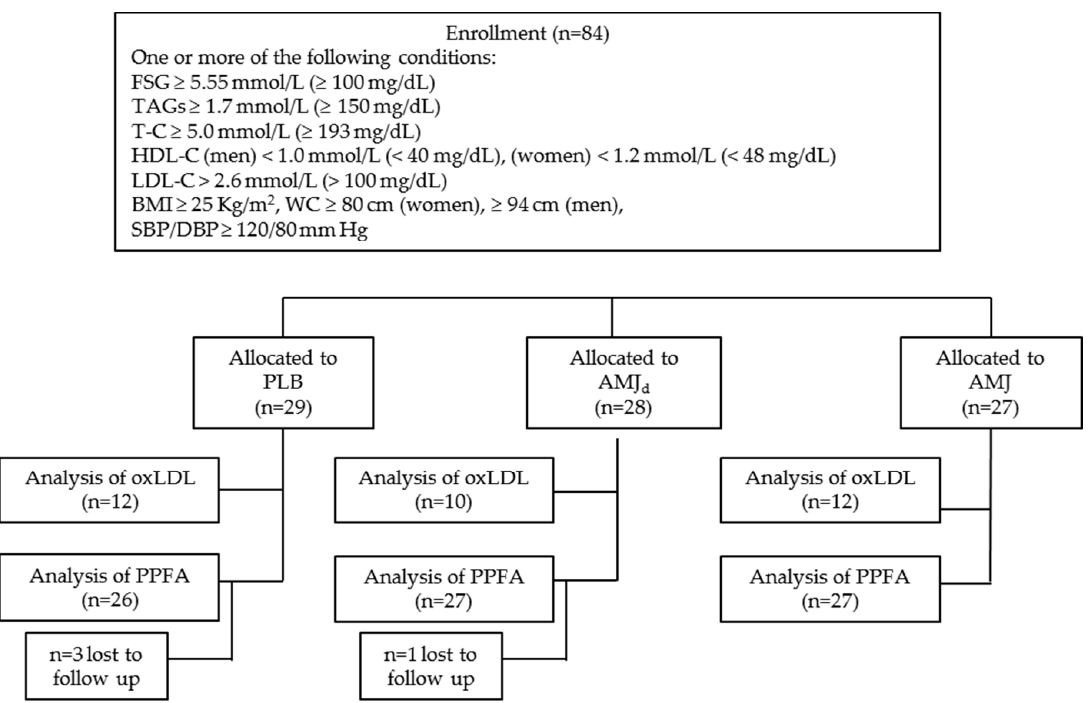
Figure 1. Flow chart indicating the number of participants selected and allocated to the different intervention groups and analyses. FSG: fasting serum glucose; TAGs: triglycerides; T-C: total- cholesterol; HDL-C: High-density lipoprotein-cholesterol; LDL-C: low-density lipoprotein- cholesterol; BMI: body mass index; SBP: systolic blood pressure; DBP: diastolic blood pressure; oxLDL: oxidized low-density lipoprotein; PPFA: plasma phospholipids fatty acids; PLB: placebo; AMJ d : polyphenol low-dose chokeberry juice; AMJ: polyphenol high-dose chokeberry juice.